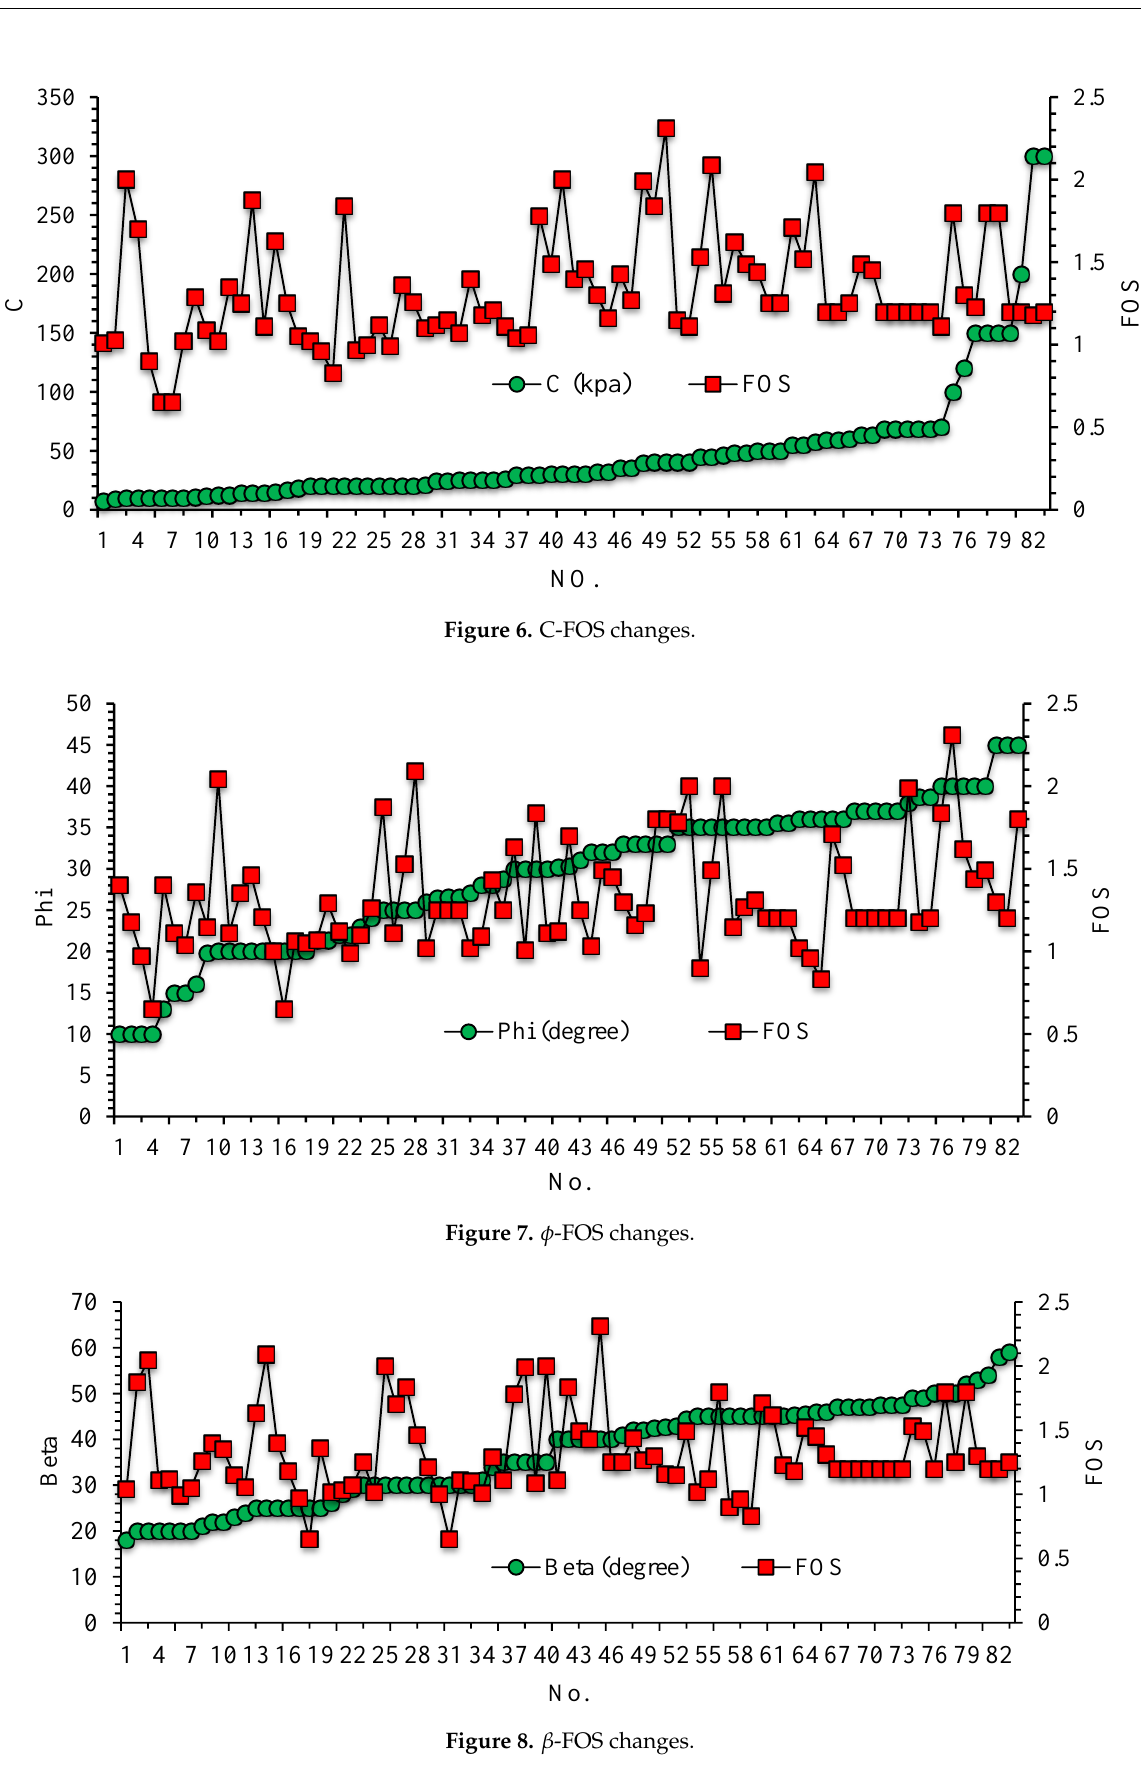
Figure 5. Density-FOS changes .